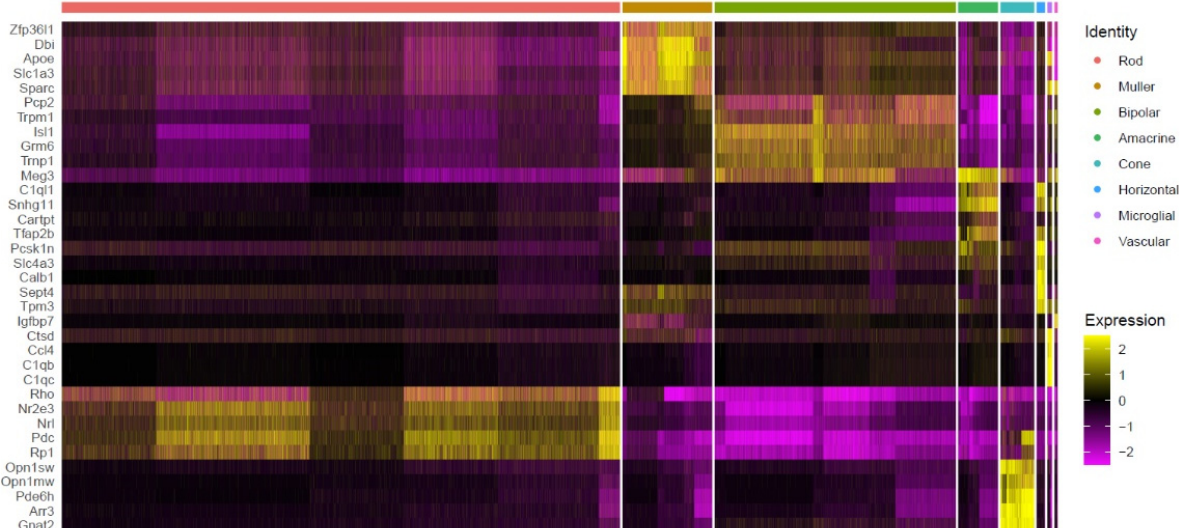
Figure 3. Expression of 35 marker genes across eight cell types in WT and rd1 retina. The Seurat FindMaker function was used to analyze differences between cell populations and to screen each population for genes with an |avg_log 2 FC| > 0.58 and a p − value < 0.05 relative to all other cells. The heat map displays expression of the top 35 enriched genes across the 43,979 identified cells, pooled from all WT and rd1 retinal samples. Individual cells are grouped into the eight most abundant cell types on the x − axis, while genes are organized along the y − axis. A more yellow color indicates that a cell population highly and specifically expresses a given gene, magenta indicates low gene expres- sion.